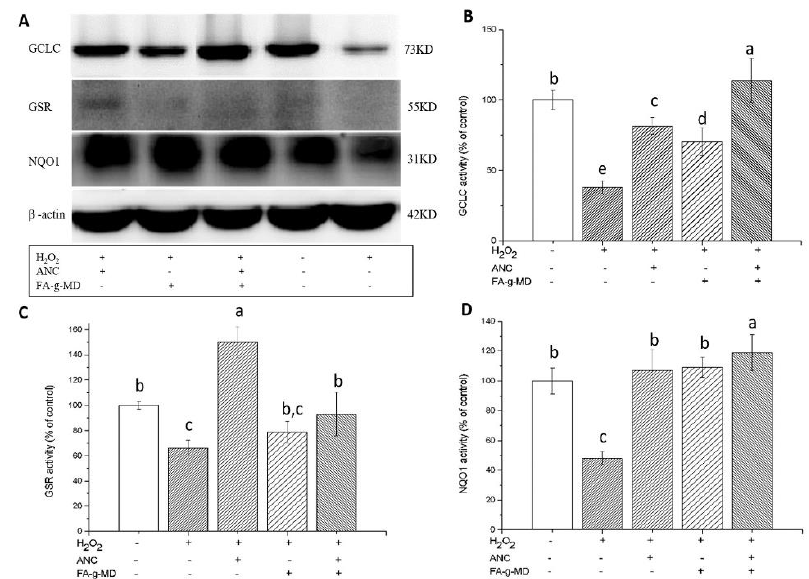
Figure 6. Effects of ANC, FA-g-MD and their combination on the protein expression of GCLC, NQO1, GSR and β -actin in HT-29. ( A ) Western blot representative of three enzyme proteins and control. ( B – D ) The values from densitometry of GCLC, GSR and NQO1 (normalized to the level of β -actin). The values are expressed as mean ± SD (n = 3). a–e Mean values with unlike letters were significantly difference.